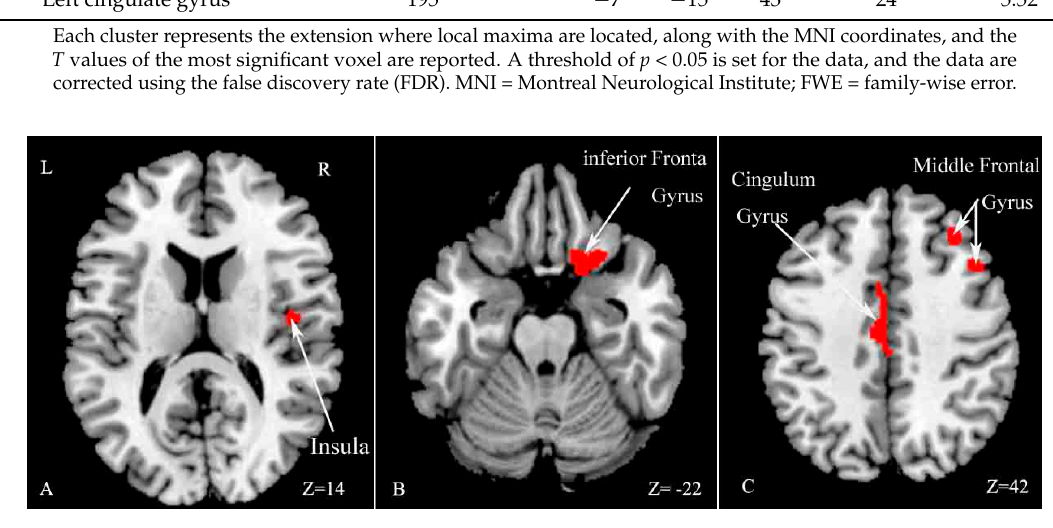
Figure 2. Statistical parametric mapping (SPM) regions with decreased gray matter (GM) volume in patients compared with healthy controls ( p < 0.05, family-wise error (FWE) corrected for multiple comparisons). SPM regions exhibiting significant GM loss: right insula ( A ); right inferior frontal gyrus ( B ); right middle frontal gyrus and left cingulate gyrus ( C ). R: right; L: left.